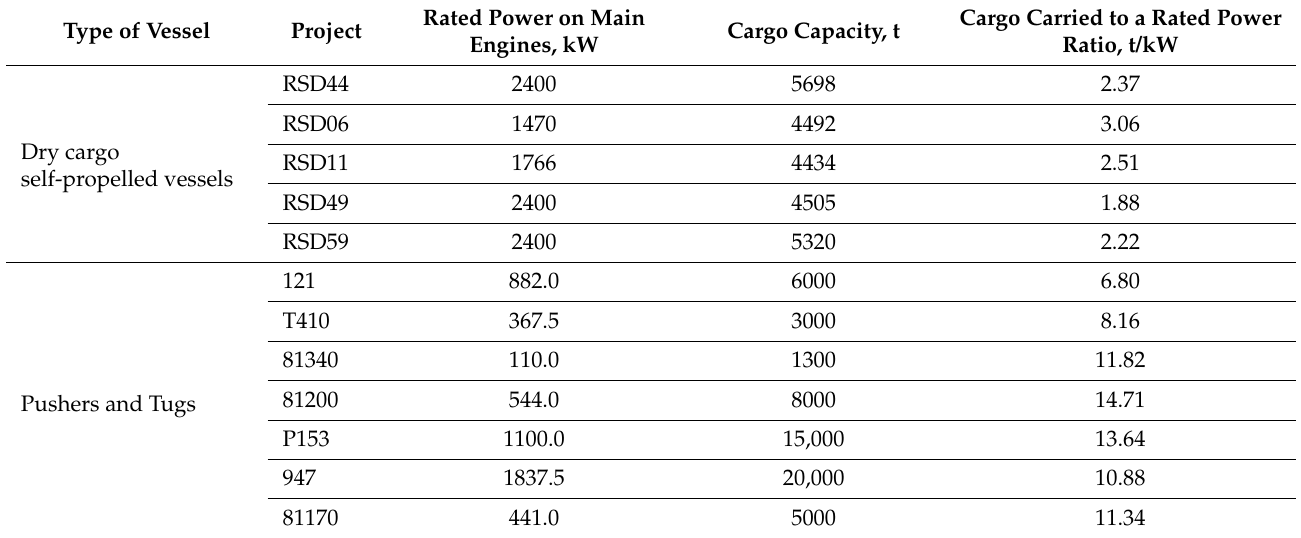
Table 4. Characteristics of river